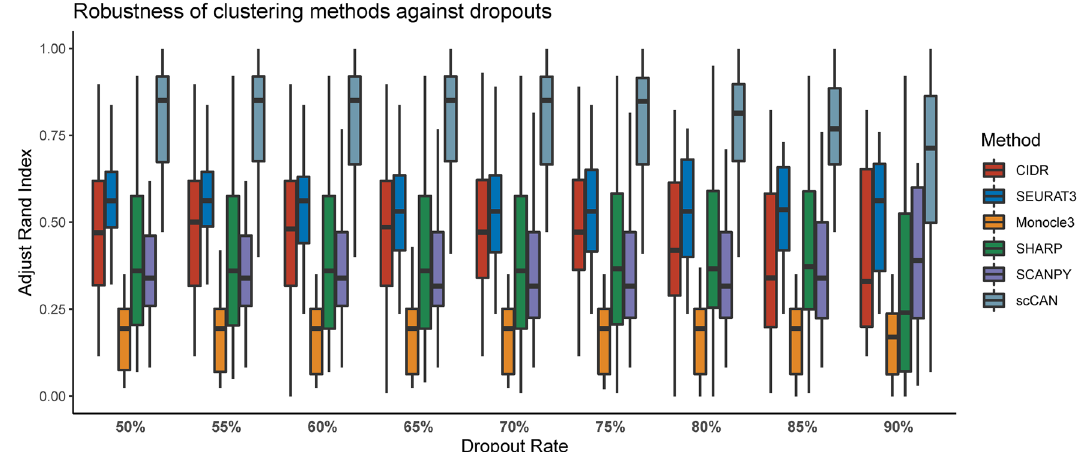
Figure 4. Assessment of CIDR, SEURAT3, Monocle3, SHARP, SCANPY and, scCAN against dropouts. Simulations were obtained by varying the number of zeros in each of 27 real biological datasets from 50% to about 90%, respectively. Each box plot shows the ARI values obtained from each method for a specific dropout portion. Wilcoxon test shows that the ARI values obtained from scCAN are significantly higher than CIDR,